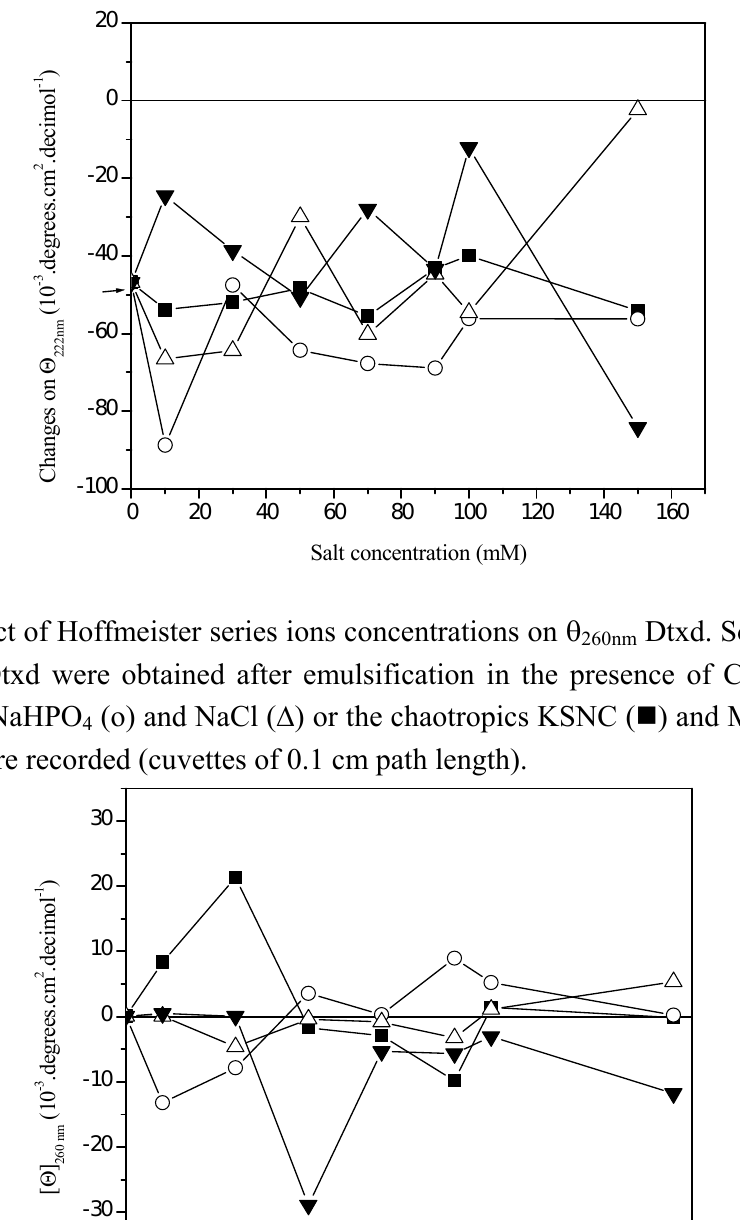
Dtxd. Soluble samples 222nm Cl and the 2 2 ( ▼ ) and 2